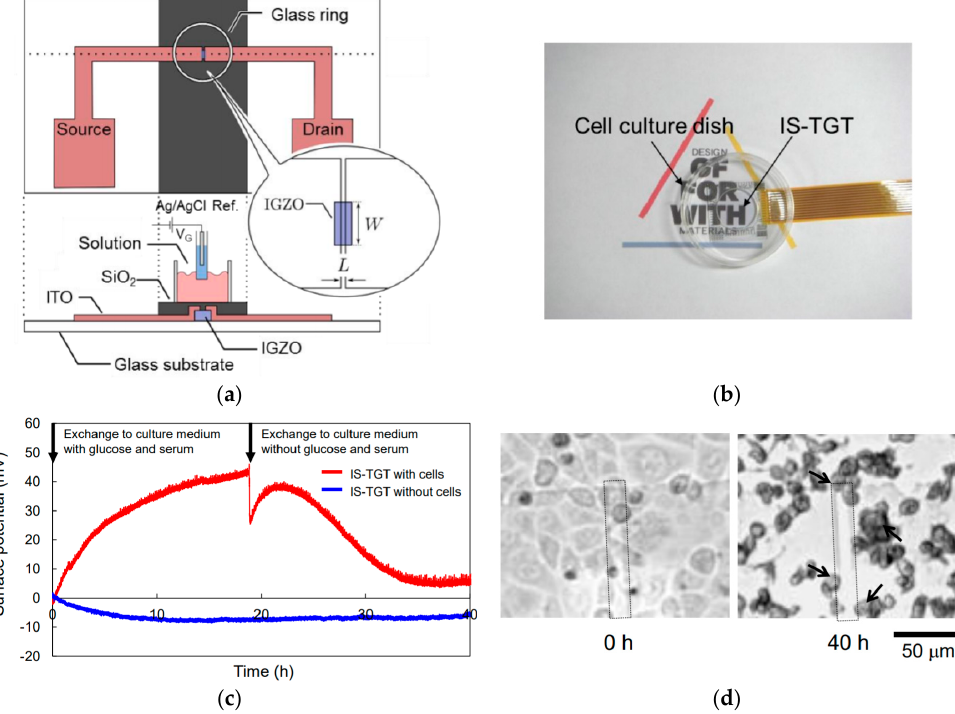
Figure 11. ( a ) Scheme of the ion sensitive transparent-gate transistor (IS-TGT) structure; ( b ) image of a cell culture dish with IS-TGT; ( c ) change in surface potential measured by the IS-TGT with HeLa cells in the well; and ( d ) optical micrograph of living cells (0 h) and dead cells (40 h). The gate area is shown by the dotted line. Adapted with permission from Sakata et al. [2]. Copyright © 2017 American Chemical Society.